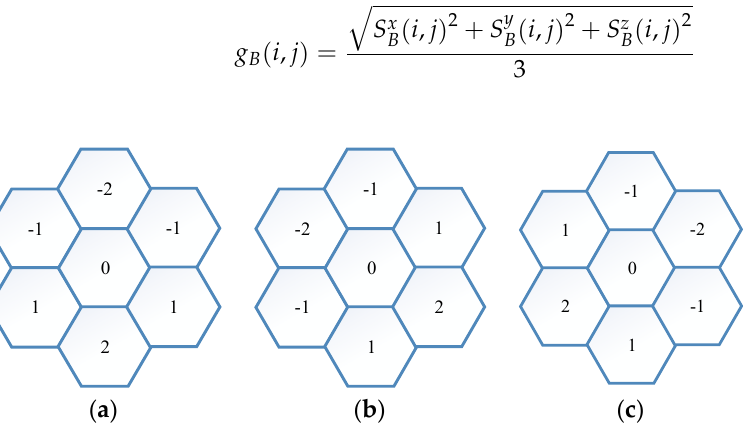
Figure 7. Sobel operator for hexagonal pixel image. ( a ) Gradient in the vertical direction ( x ); ( b ) gradient 60° to the left ( y ); ( c ) gradient 60° to the right ( y );